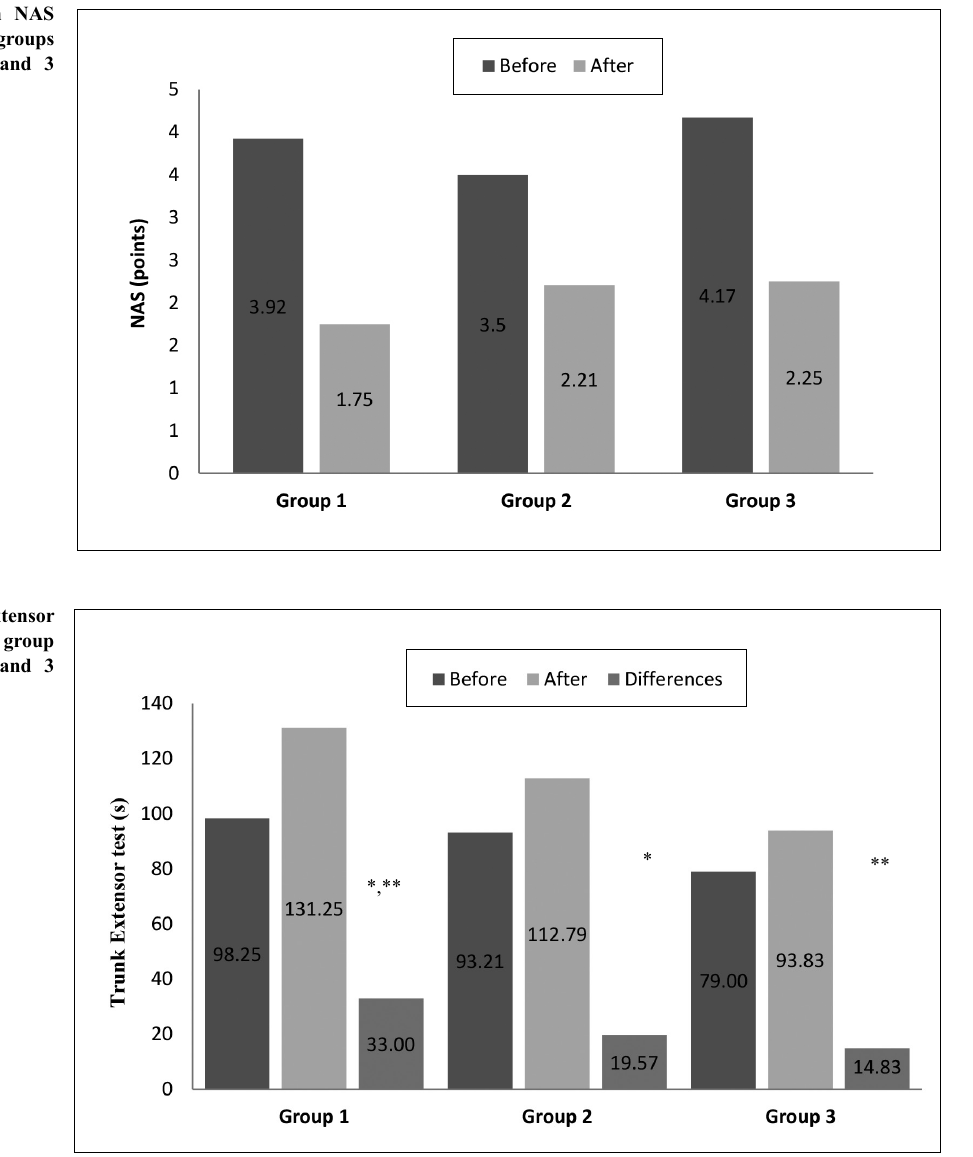
Figure 1. Differences in NAS